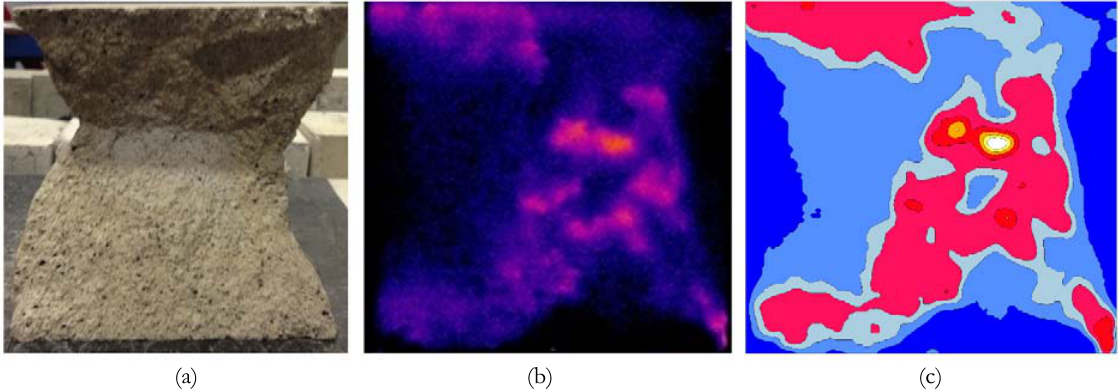
Figure 11: a) picture after the breakage of the specimen; b) original IR image and c) processed IR image before of the